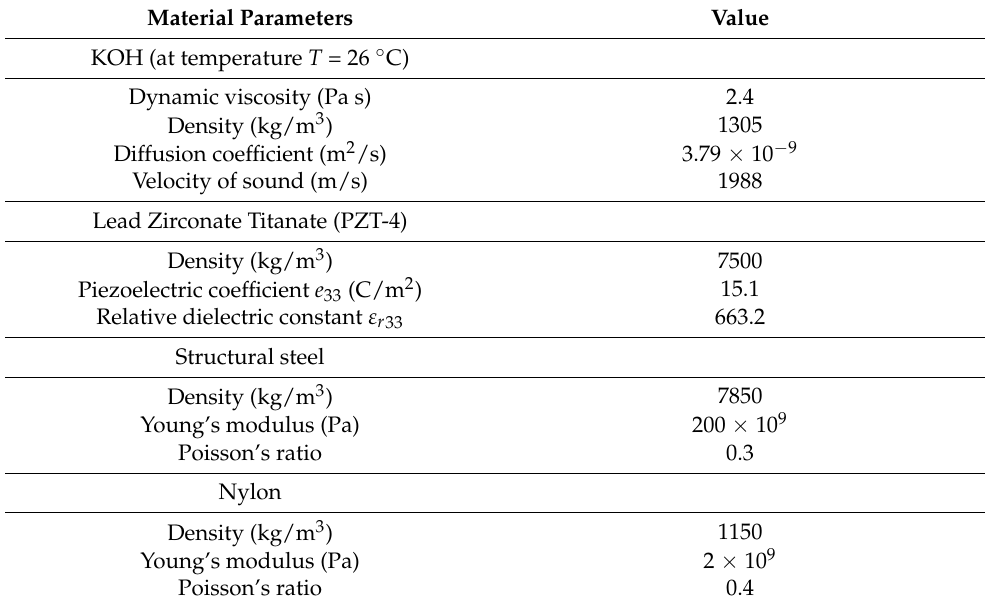
Table 1. Material property parameters used in the FEM